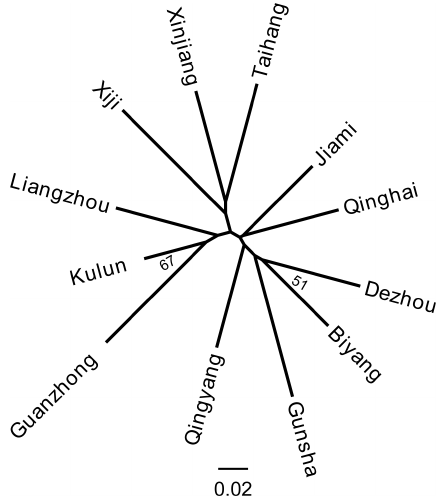
Figure 4. Neighbor-joining tree based on DR of 12 Chinese donkey